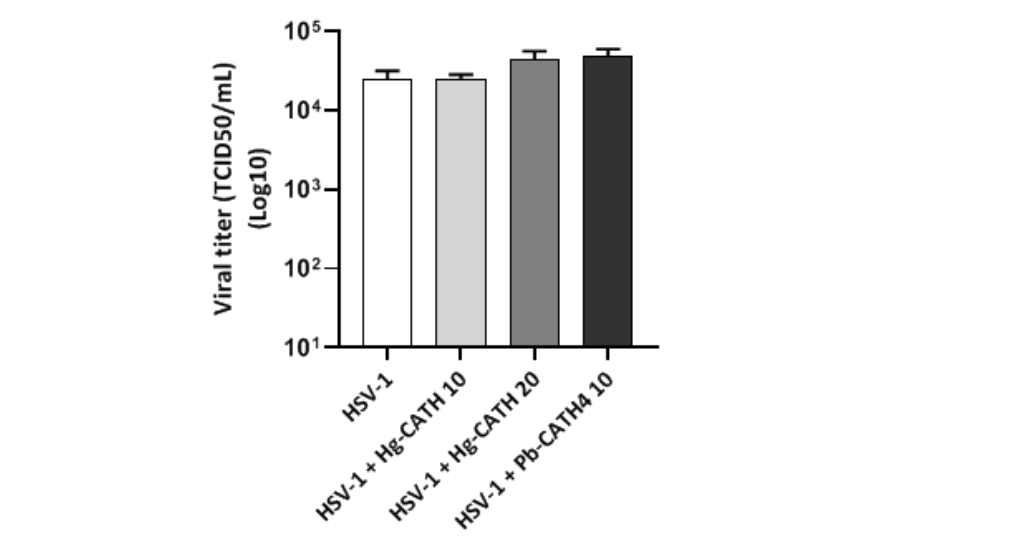
Figure 4. Evaluation of virucidal effect of Hg-CATH and Pb-CATH4. HSV-1 suspension was pre- incubated in absence or presence of Hg-CATH (10 and 20 µg/mL) and Pb-CATH4 (10 µg/mL) for 1 h at 37 °C before titration by endpoint dilution assay on Vero cells. Viral titres are expressed in TCID50/mL. Data are represented as mean + SEM of three independent experiments.